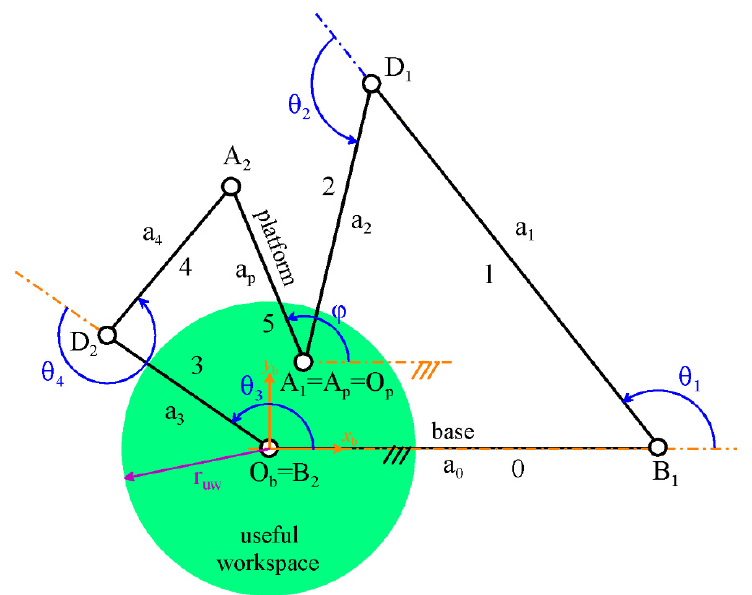
Figure 2. Scaled top view of a LaMaViP’s CRS-RRC sized according to the results of the dimensional synthesis [19].